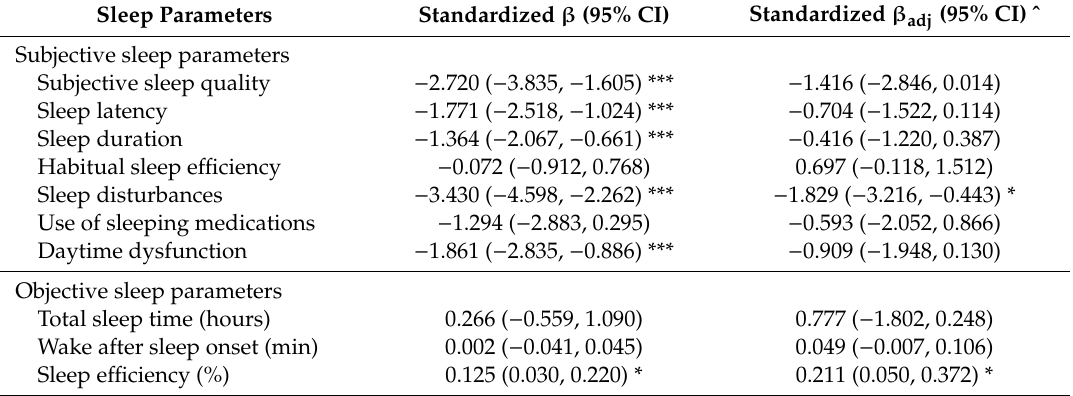
Table 3. Association between objective and subjective sleep parameters on physical health-related quality of life.